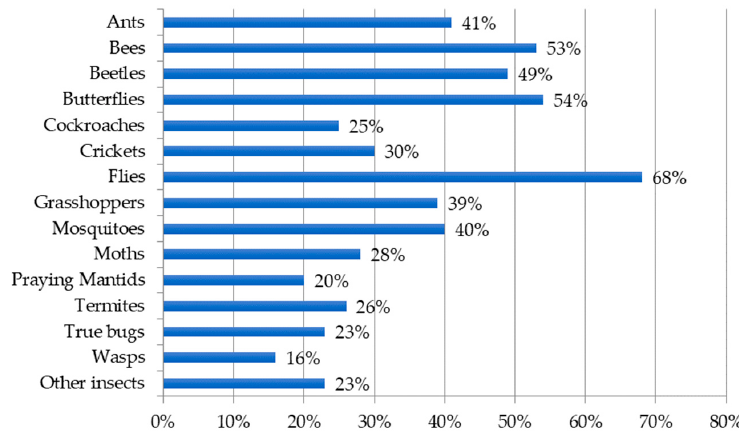
Figure 1. Insect types incorporated.